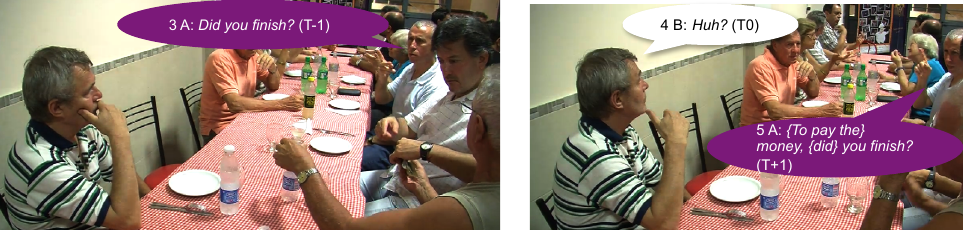
Figure 1. ‘Did you finish?’ , Person A on the right asks Person B on the left (line 3).